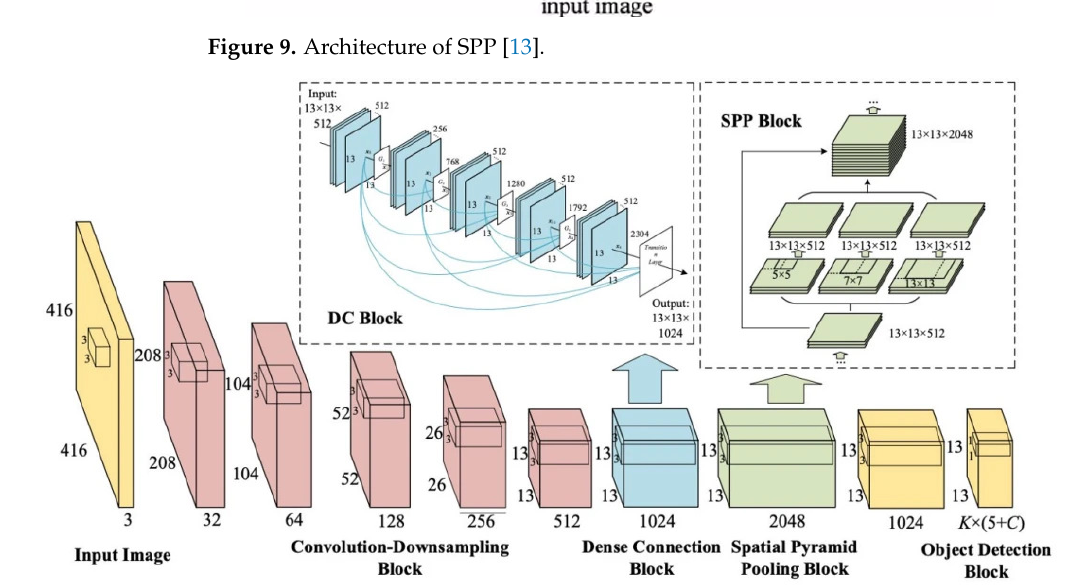
Figure 9. Architecture of SPP [13].